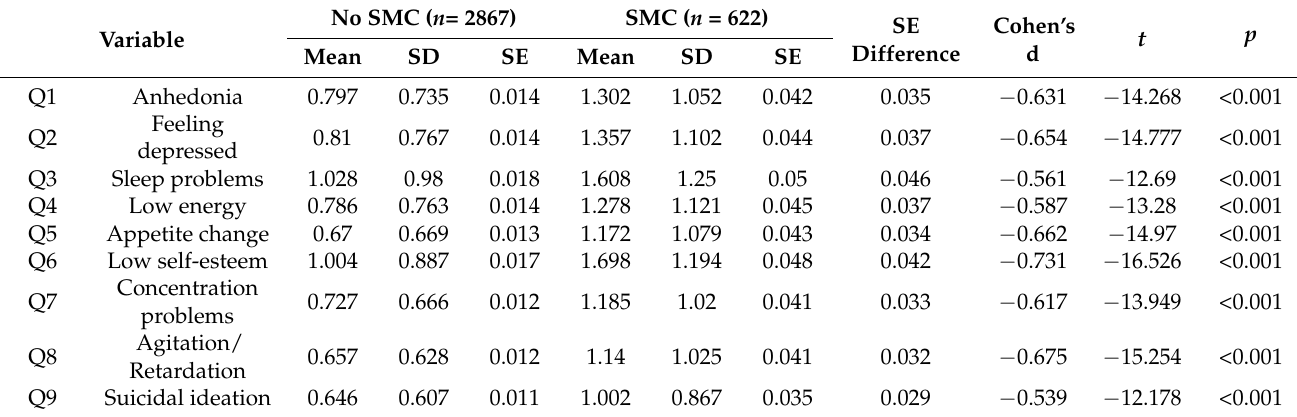
Table 1. Group differences in each PHQ-9 item.